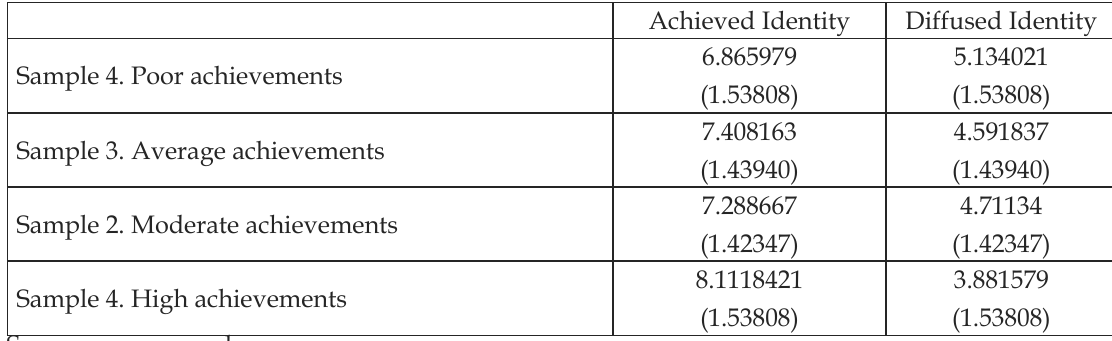
Tab.1. Descriptive data for identity statuses in samples formed by achieve- ments